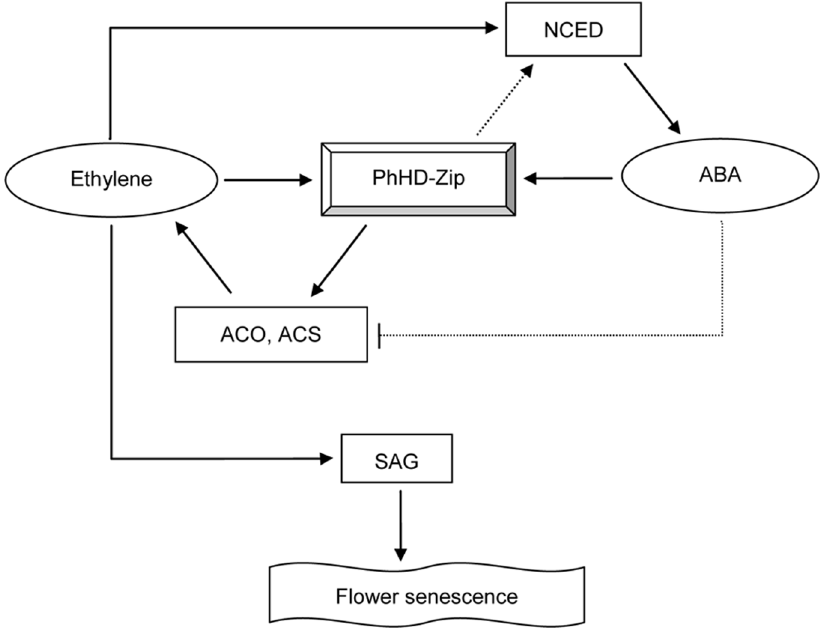
Figure 9. The model of PhHD-Zip regulating flower senescence. Solid lines denote relationships supported by our study and those of other researchers; dashed lines denote hypothetical relationships.